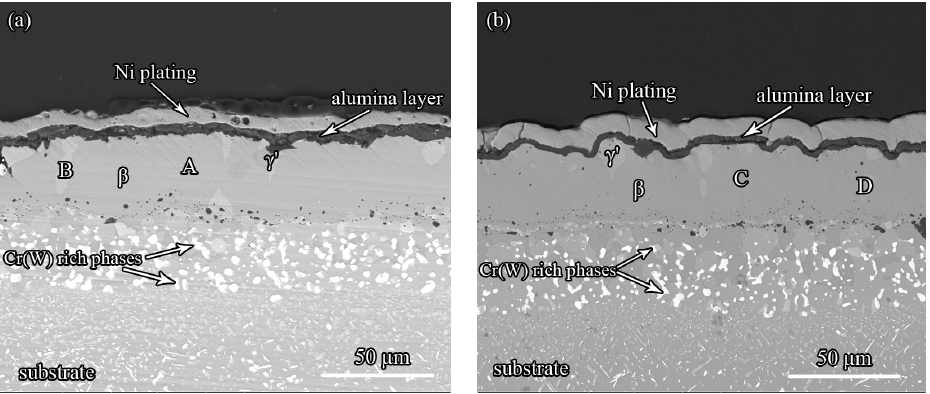
Figure 11. The cross ‐ sectional morphologies of the coatings after oxidation at 1100 °C for 320 h: ( a ) PtAl; ( b ) PtZrAl.